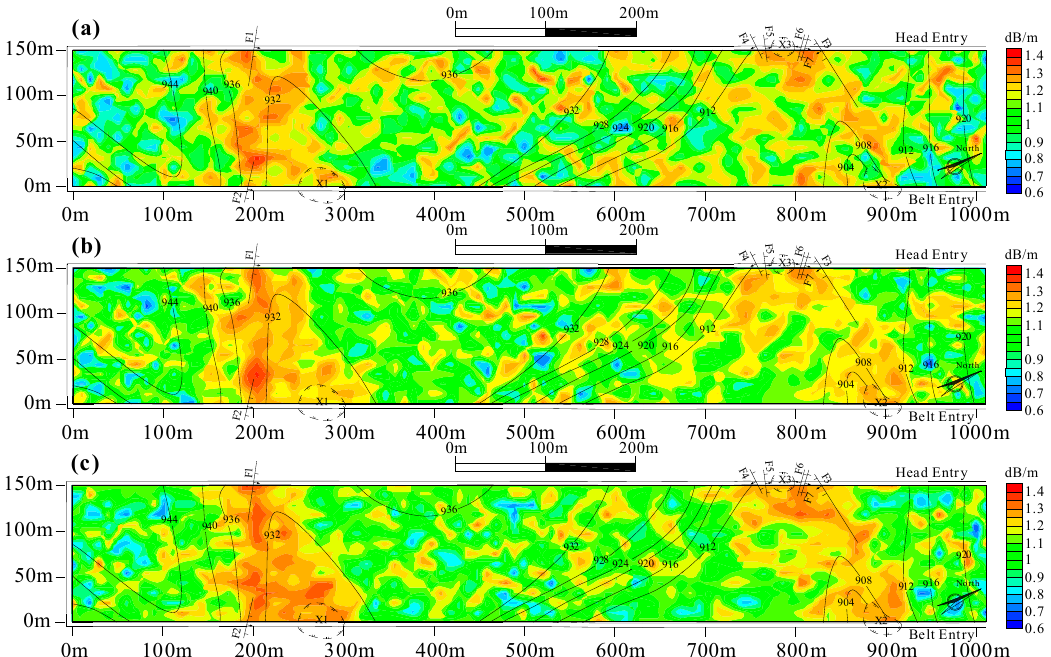
Figure 10. Reconstructed results according to the three algorithms after 500 iterations. ( a ) Inversion result from the SGA; ( b ) inversion result from the AMPGA; ( c ) inversion result from the AMPGA with constraints.